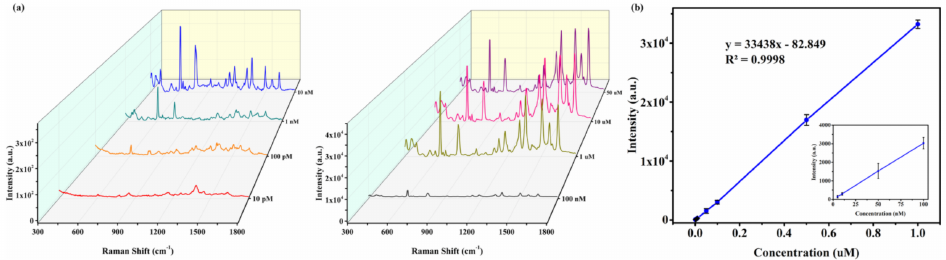
Figure 7. ( a ) Concentration-dependent SERS spectra for R6G with different concentrations (10 pM–50 µ M); ( b ) the corresponding linear relationship of SERS intensities at 610 cm − 1 versus corresponding R6G